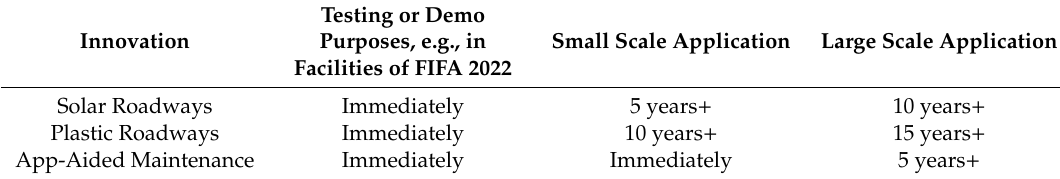
Table 1. Innovative concept readiness level